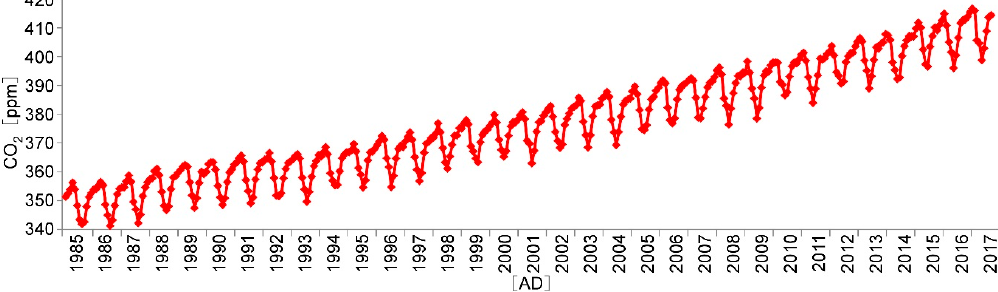
Figure 2. Change of CO 2 concentration on the ground surface at Ogata (40° N, 140° E) during the last 30 years calculated by Global Spectral Atmosphere Model-Transport Model (GSAM-TM) [33].